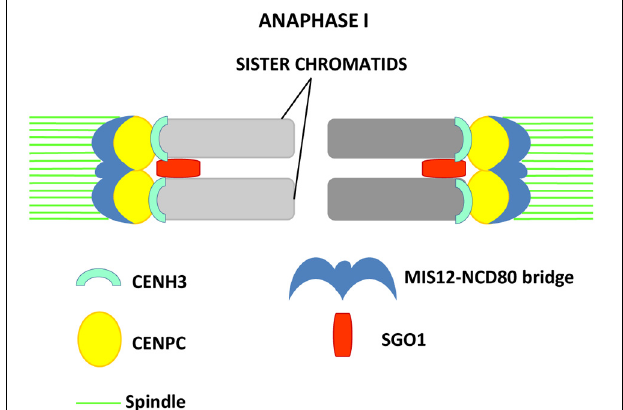
FIGURE 2 | Model proposed in maize by Li and Dawe (2009) for reductional segregation in meiosis I. Sister kinetochores are fused in meiosis I by formation of the MIS12-NCD80 bridge that, together with SGO1, allows monopolar attachment of sister chromatids to the spindle pole. The inner kinetochore proteins CENPC and CENH3 are visualized as two distinct